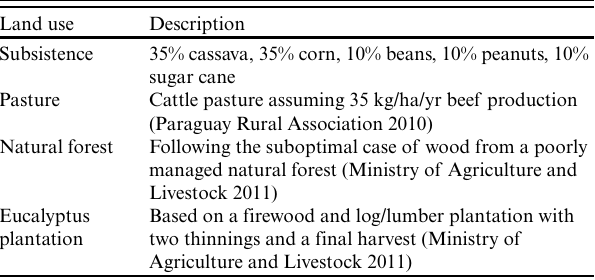
Table 1 . Land uses in the general ecosystem-service model.